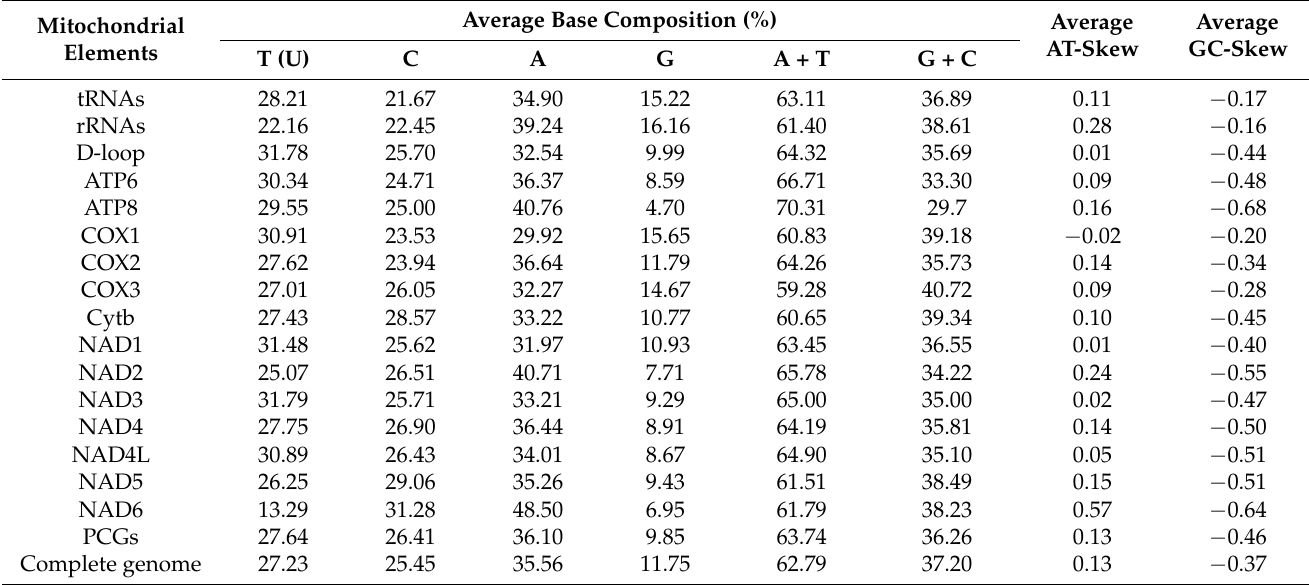
Table 3. Base composition statistics of complete mitochondrial genome and each